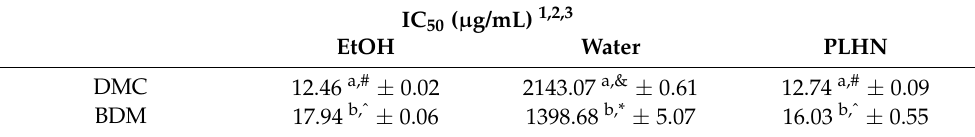
Table 2. Antioxidant activity of free and curcuminoids DMC and BDM-loaded